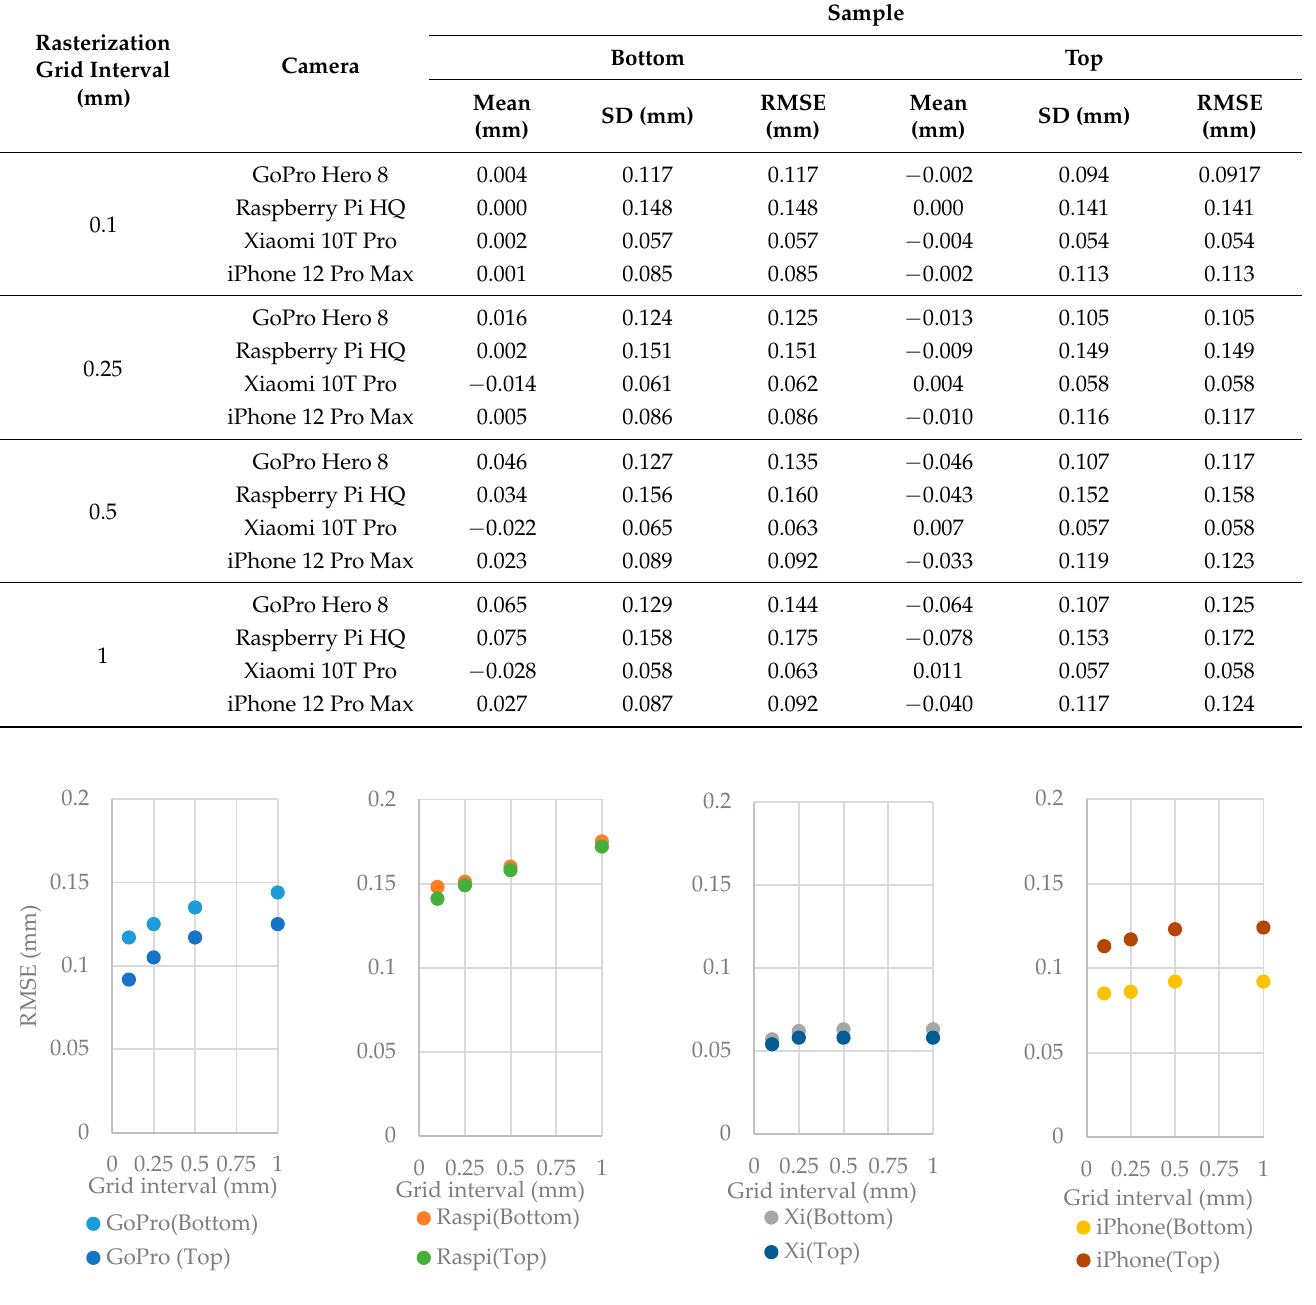
Figure 8. The root mean square error (RMSE) of the cloud-to-cloud distance between each low-cost camera model compared to Canon EOS 5DS R DSLR for the top and bottom samples with different rasterization grid interval.